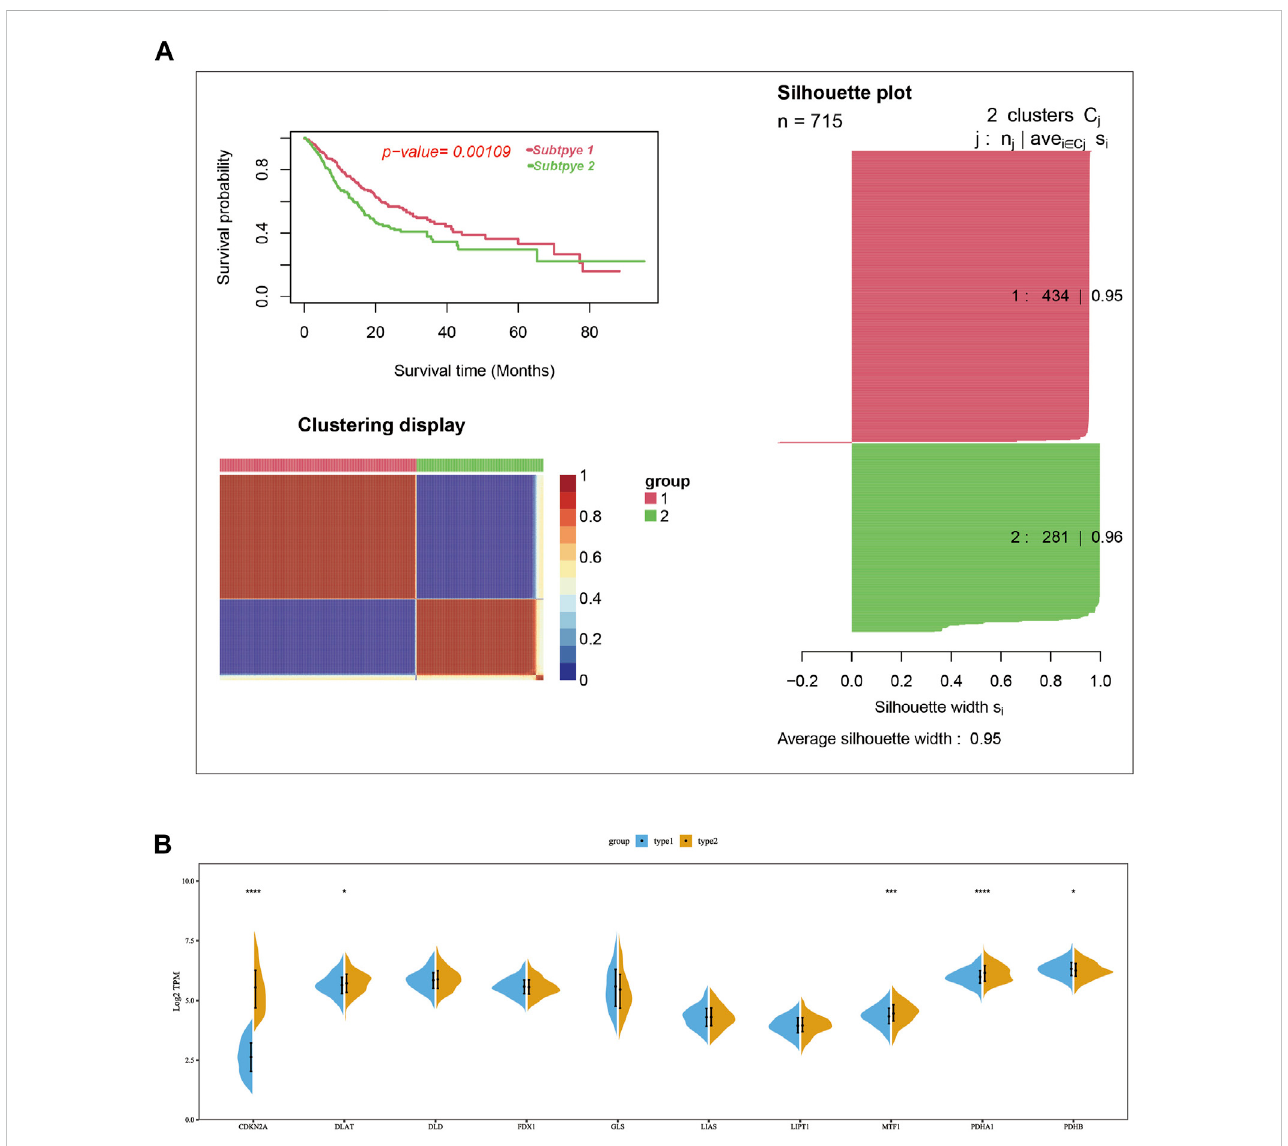
FIGURE 2 Twocuproptosis-relatedsubtypesofLUADwereidenti fi edusingtheconsensusclustermethod. (A) TwoLUADsubtypeswereobtainedaccordingtothe mRNA expression of cuproptosis-related genes using the consensus clustering in the merge cohort, in which subtype 1 had a poorer prognosis compared with sub type 2. (B) The mRNA expression difference of ten cuproptosis-related genes between two subtypes in merge cohort. In the silhouette plot of Figure 2A, each row represent the Silhouette Coef fi cient (range from 0 – 1) of each sample, higher Silhouette Coef fi cient means better clustering effect, the average Silhouette Coef fi cient for subtype 1 and 2 were .95 and .96. The symbols *, **, ***, *** corresponded to p < .05, .01, .001, .0001, respectively. p < .05 was regarded as signi fi